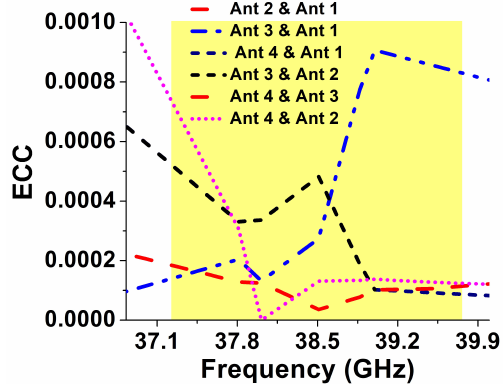
Figure 11. ECC for the proposed 5G MIMO antenna.